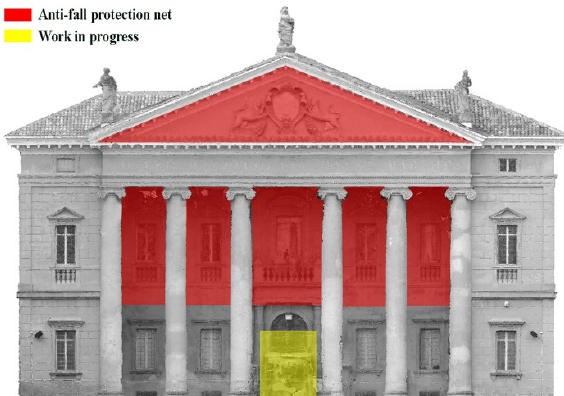
Figure 2. Survey artificial obstacles